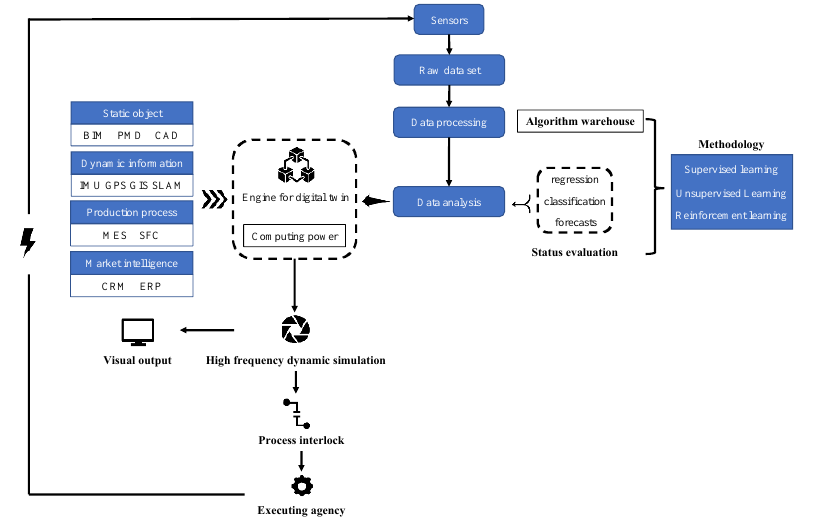
Figure 4. System operation logic.